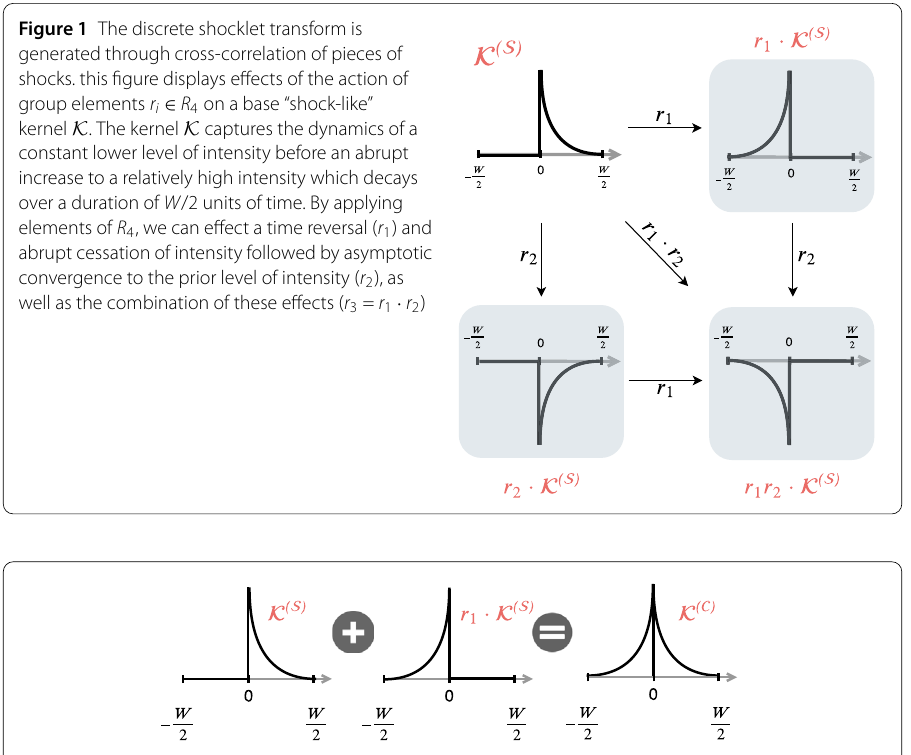
Figure 2 Shock dynamics. This figure provides a schematic for the construction of more complicated shock dynamics from a simple initial shape ( K ( S ) ). By acting on a kernel with elements r i of the reflection group R 4 and function concatenation, we create shock-like dynamics, as exemplified by the symmetric shocklet kernel K ( C ) = K ( S ) ⊕ [ r · K ( S ) ] in this figure. In Sect. 2.3 we illuminate a typology of shock dynamics derived from 1 combinations of these basic